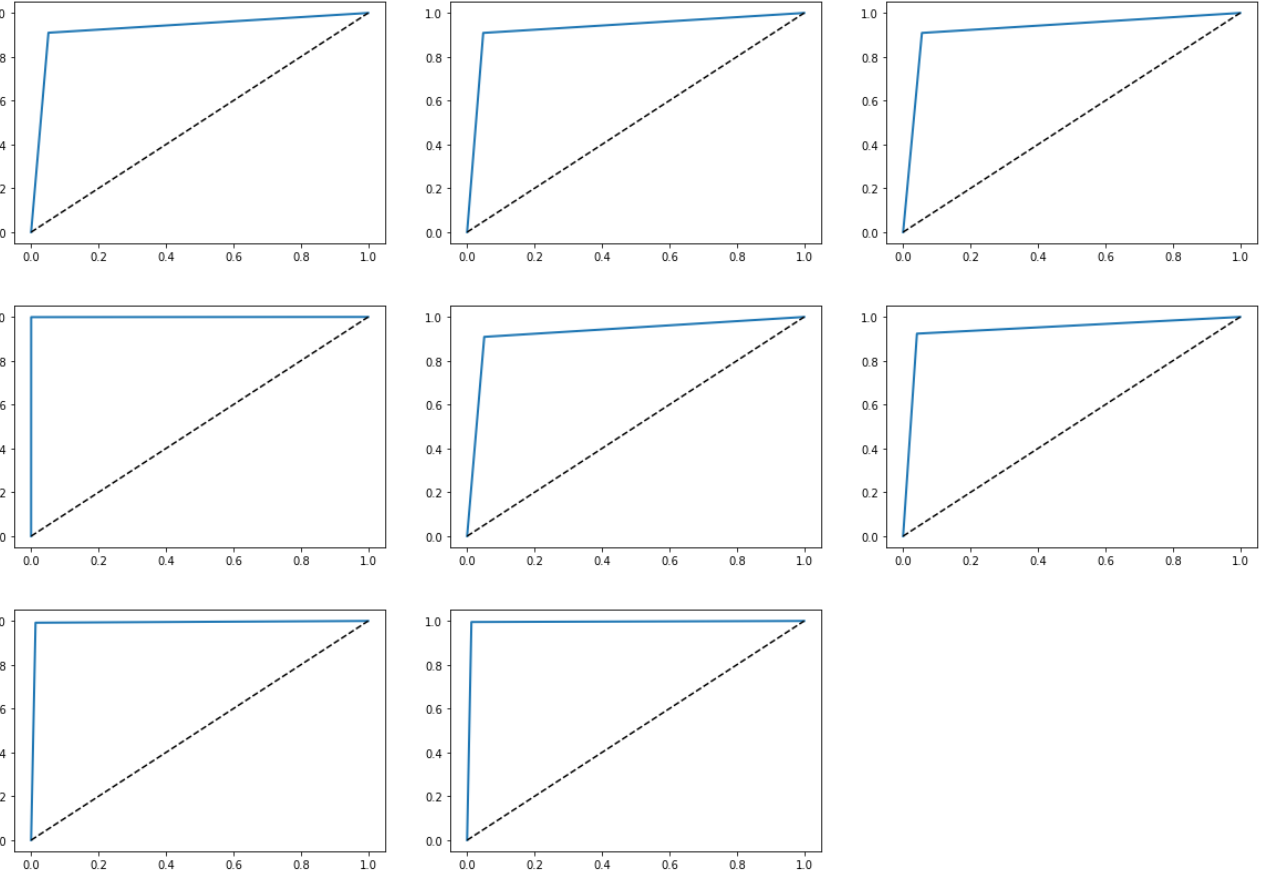
Figure 10. ROC curves of GD, SVM, LR, RF, HVG, SVG, HVR, SVR.